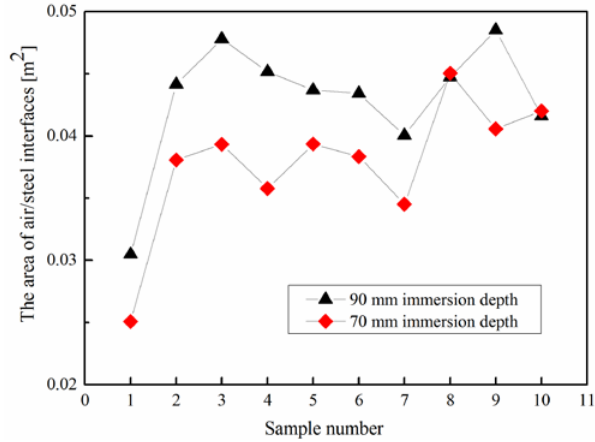
Figure 10. Overall area of air/steel interface at varied immersion depths.